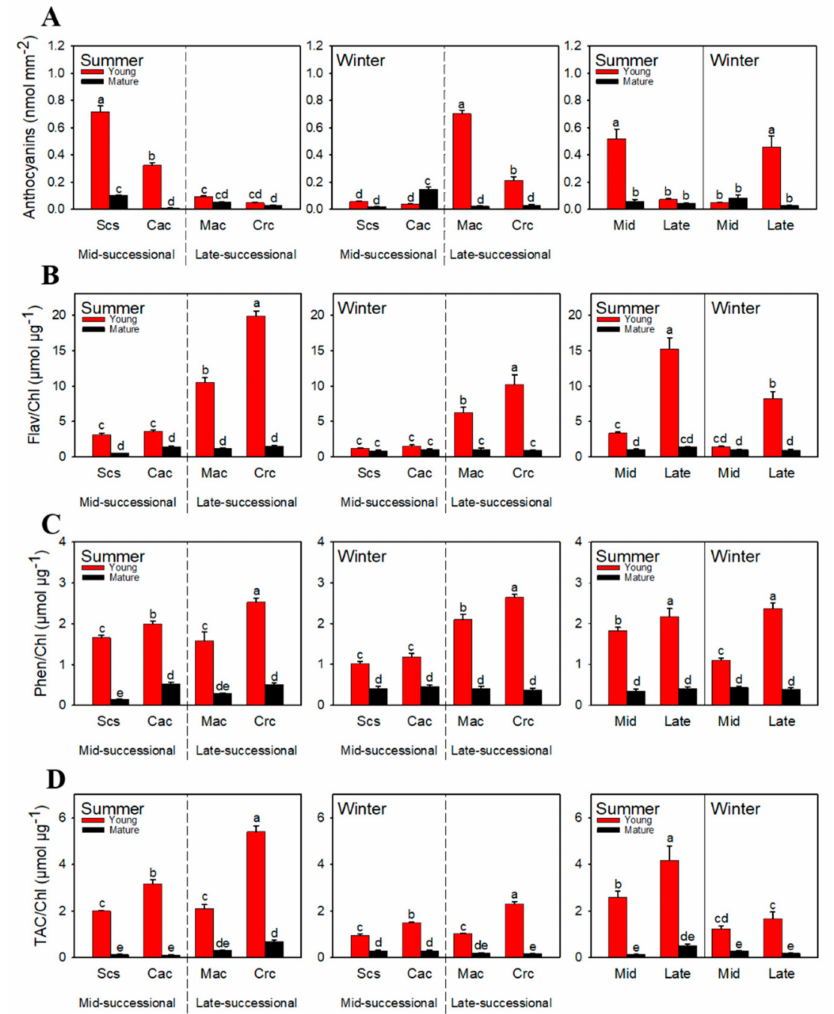
Figure 4. Anthocyanin ( A ), flavonoid ( B ), and total phenolic content ( C ) and total antioxidant capacity ( D ) of dominant species at different successional stages in different seasons. Scs, Schima superba ; Cac, Castanopsis chinensis ; Mac, Machilus chinensis ; Crc, Cryptocarya chinensis ; Mid, mid-successional tree group; Late, late-successional species tree group; Flav, flavonoids; Phen, phenolic; TAC, total antioxidant capacity. Different letters above bars indicate statistical significance ( p <